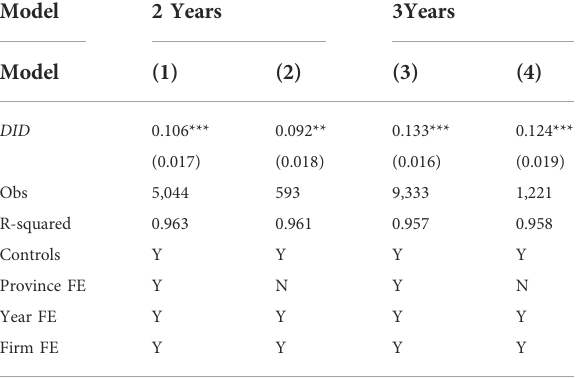
TABLE 5 Dynamic sliding window test results.